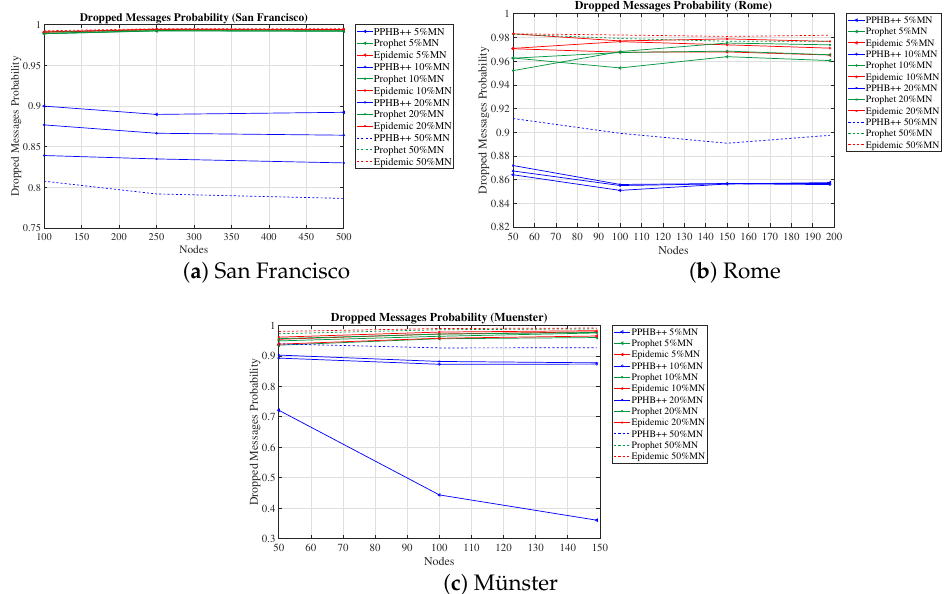
Figure 7. Dropped message probability (DMP) for the three cities of San Francisco, Rome, and Münster with the presence of malicious nodes in the network (the y-axis parameter is normalized to a scale between 0 and 1).